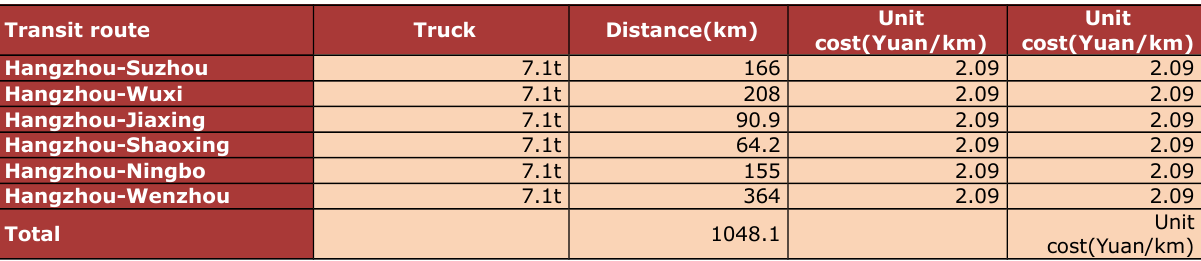
Table 4. Transport Routes and Transport Costs